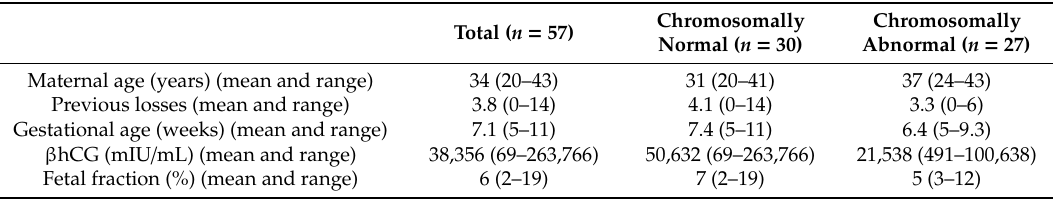
Table 1. Characteristics of cfDNA samples with corresponding products of conception (POC) results suitable for analysis (excluding triploid